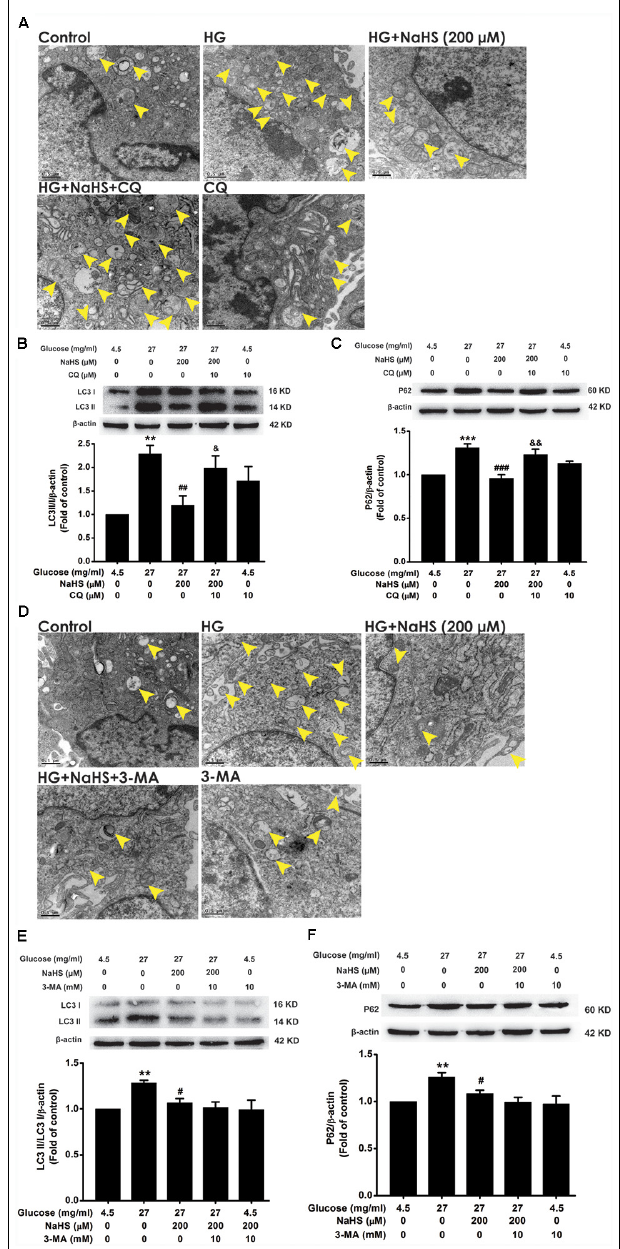
FIGURE 3 | Effects of chloroquine (CQ) and 3-methyladenine (3-MA) on the improving role of H 2 S in autophagic flux in HG-exposed HT22 cells. (A,D) Transmission electron microscope images of HT22 cells showing the change in the number of autophagosome. The yellow arrows indicate autophagosome. (B,C,E,F) The expressions of LC3II/LC3I and P62 in HT22 cells were detected by Western blotting. Values were expressed as the mean ± SEM, n = 3. ∗∗ P < 0.01, ∗∗∗ P < 0.001, vs. control group; # P < 0.05, ## P < 0.01, ### P < 0.001, vs. HG-treated alone group; & P < 0.05, && P < 0.01, vs. co-treated with NaHS and HG group.